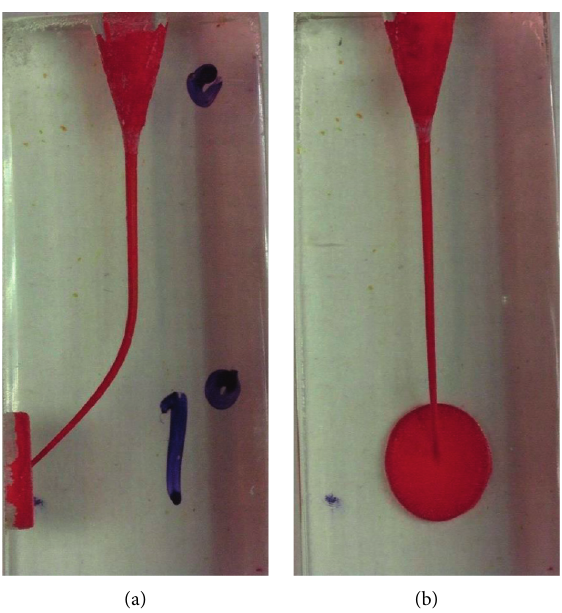
Figure 3: Endoblocks before preparation from the frontal (a) and lateral (b) view.